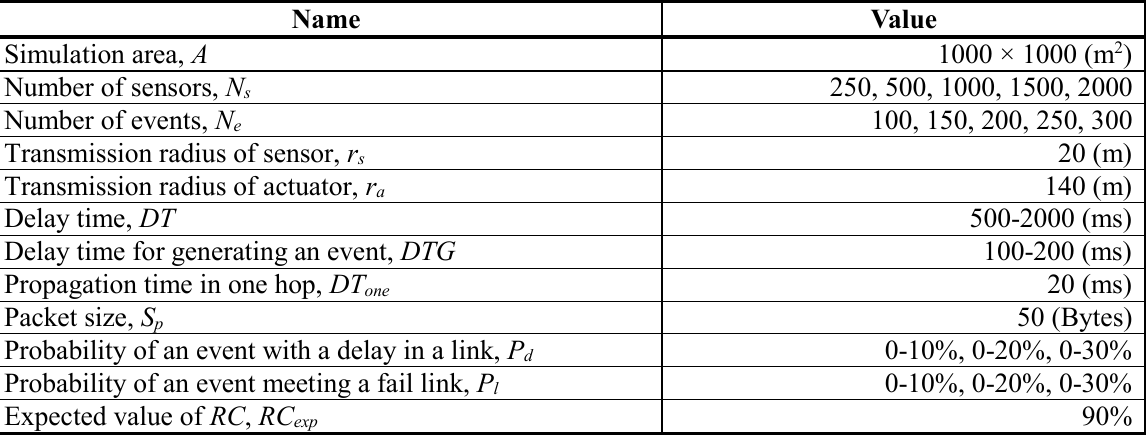
Table 2. Simulation environment